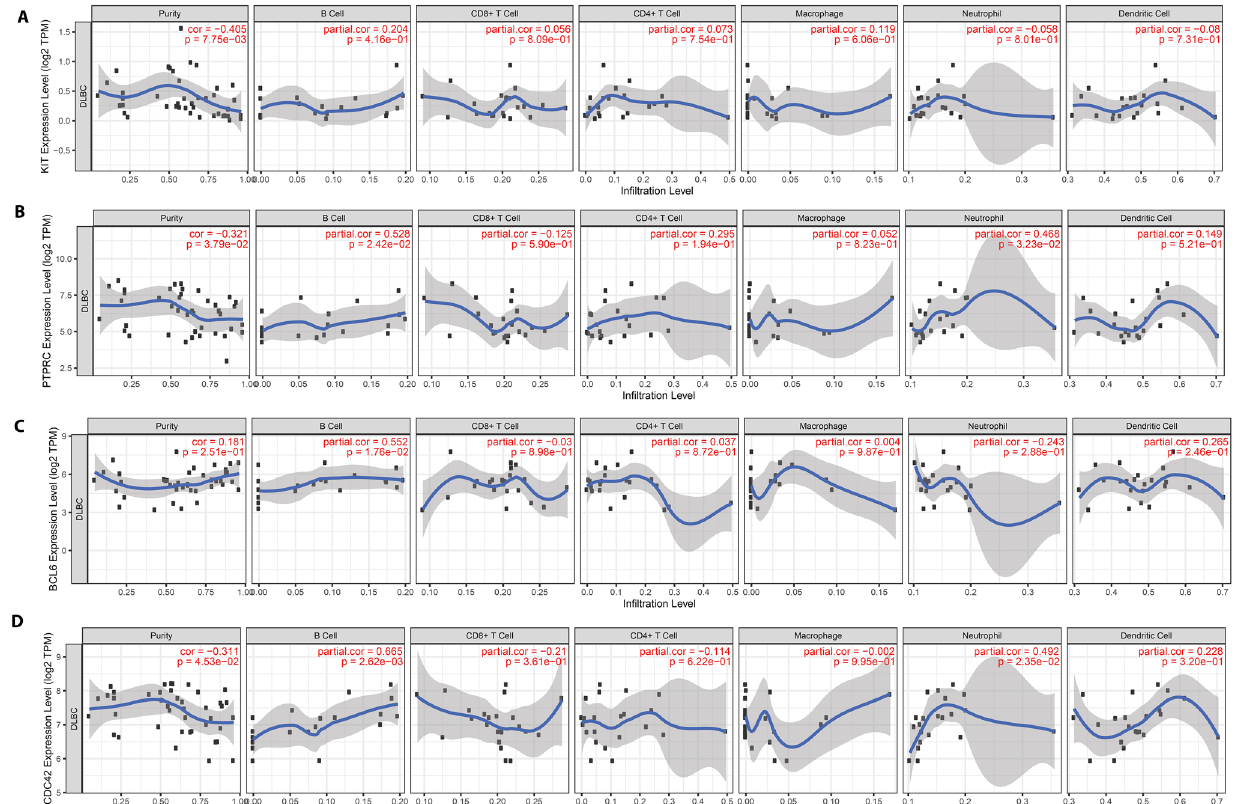
Fig. 6 Correlation analysis of MTG1, PPP2R5B, and ANXA5 mRNA expression with blood cancer (lymphoma)-infiltrating immune cells. The data are from the TIMER database (https:// cistr ome. shiny apps. io/ timer/). A Correlation of KIT mRNA with blood